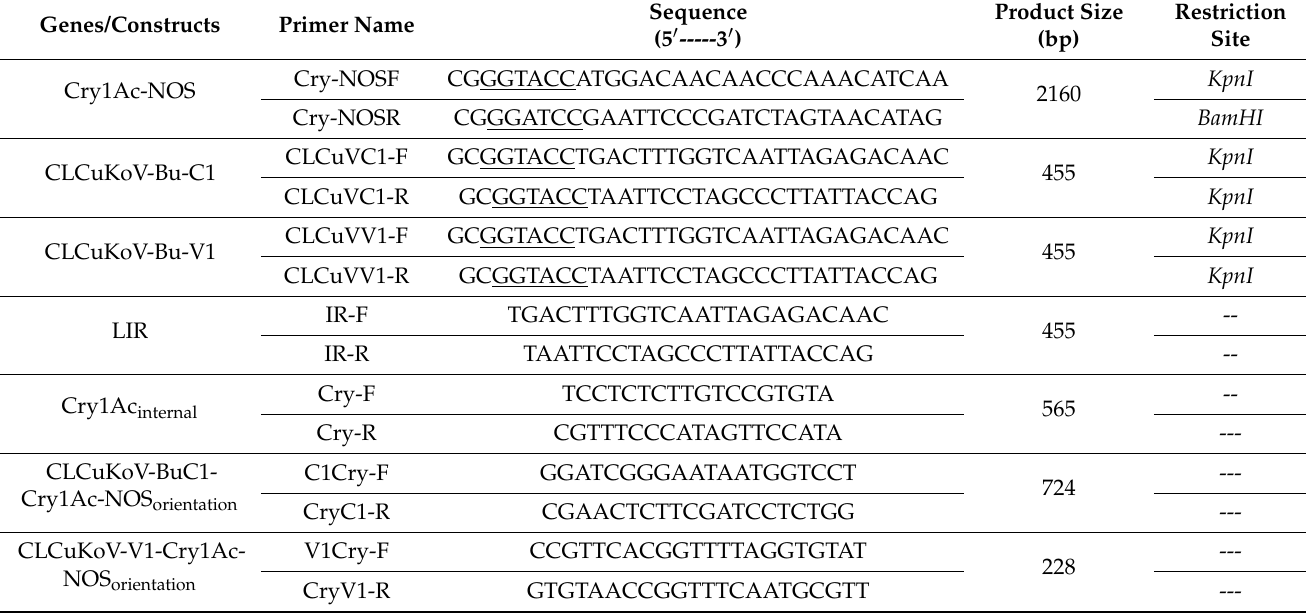
Table 2. Oligonucleotide primers, restriction enzymes, and